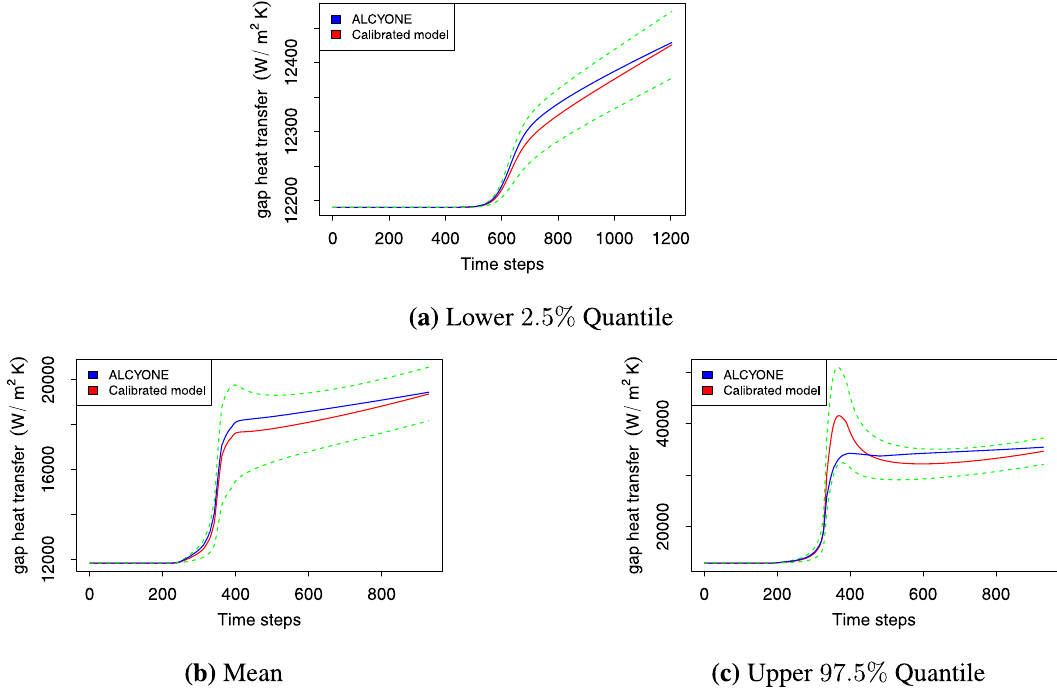
Fig. 12. 45 GWd / t H gap model prediction with its uncertainty bounds in green.